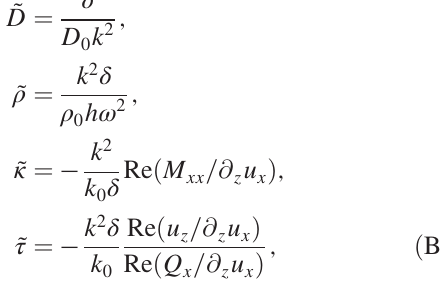
FIG. 4. Dimensionless effective parameters of the Willis metamaterial with respect to the frequency. FIG. 5. Theoretical values of reflection amplitude j r j and phase arg ð r Þ from both sides for the lossless case obtained from effective